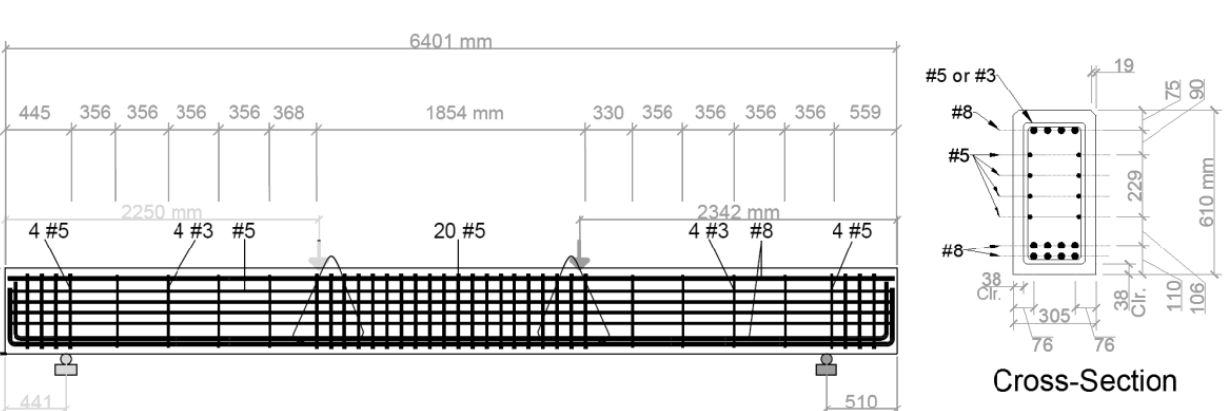
Figure 9. Dimensions and reinforcement details of the RC beam used as a case study (the rebars diameters are indicated as per the U.S. system, e.g., #3, #5, etc.)